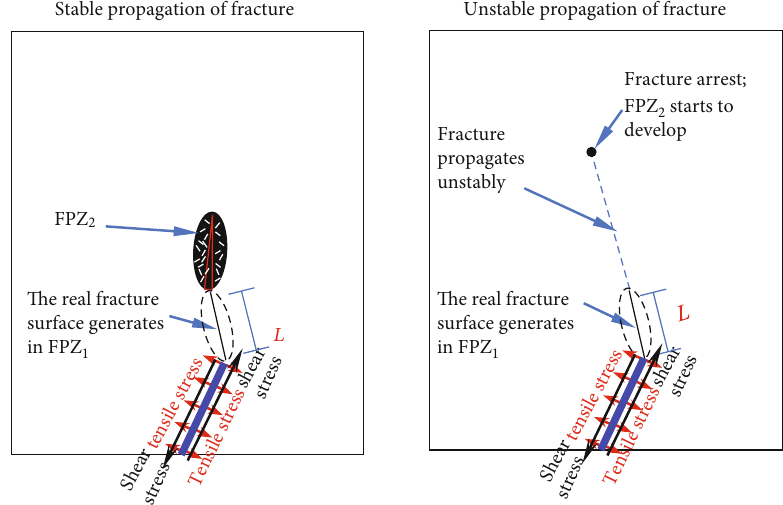
Figure 7: Comparison between stable and unstable propagations of mixed-mode